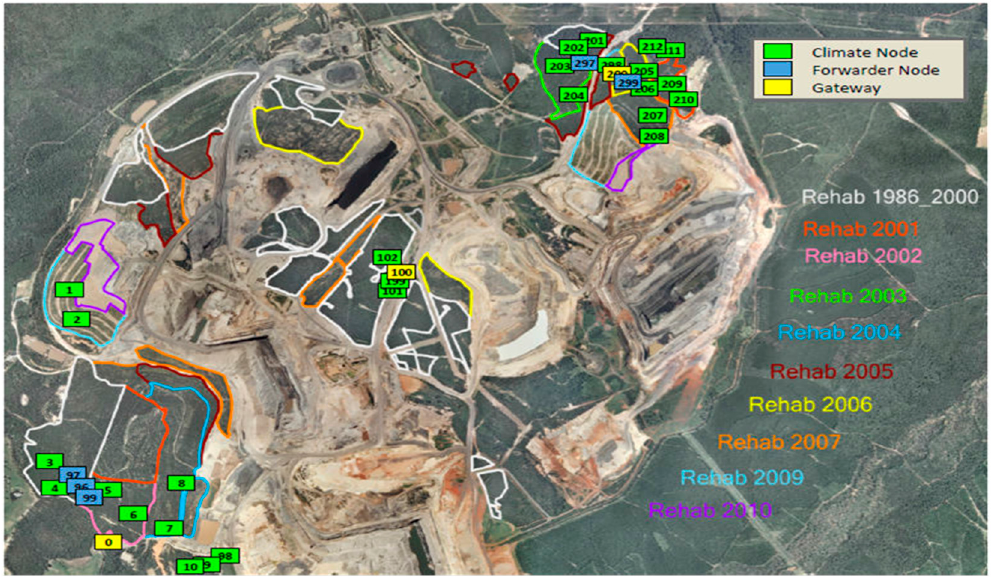
Figure 1. Meandu mine rehabilitation site and sensor deployment.